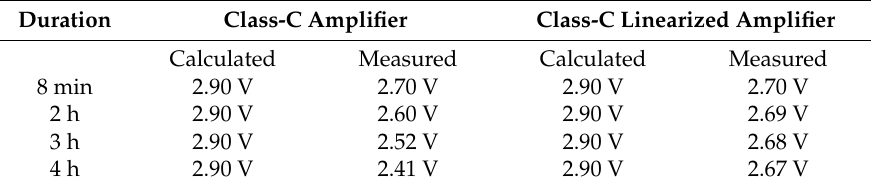
Table 1. The DC bias voltages of the class-C amplifier and class-C linearized amplifier. Duration Class-C Amplifier Class-C Linearized Amplifier